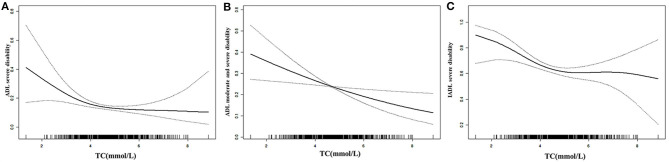
Cubic spline curve of the inverse correlation between Total Cholesterol Levels and different types of disability [(A), ADL moderate and severe disability; (B), ADL severe disability; (C), IADL severe disability] in Hainan centenarians after adjusting for covariates.